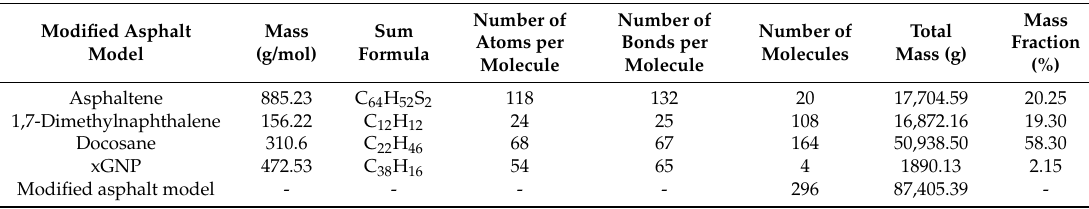
Table 1. The composition of xGNP modified asphalt